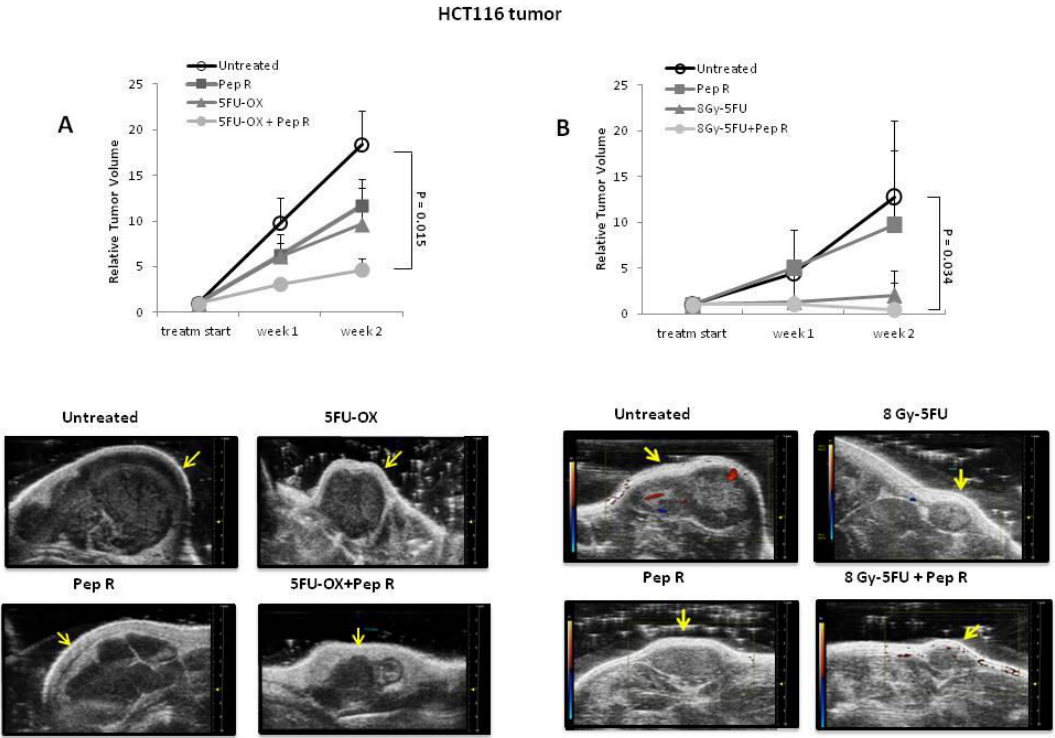
Figure 1. Peptide R reduces HCT116 tumor growth and improves the e ffi cacy of radiotherapy chemotherapeutic agents (RT-CT) in colon cancer HCT116-xenograft. ( A Upper ): Relative tumor volumes ± SEM (6 animals / group). Significance p < 0.05. Repeated measures (RM) ANOVA with Bonferroni post hoc test and correction for multiple testing by Bonferroni’s adjustment. ( A Lower ): tumors high frequency ultrasound (HFUS) conducted at 14 days of treatment (scale bar on the right). ( B Upper ): relative tumor volumes ± SEM (6 animals Control and 4 animals for each treatment group). Significance p < 0.05. RM ANOVA with Bonferroni post hoc test and correction for multiple testing by Bonferroni’s adjustment. ( B Lower ): color doppler high frequency ultrasound (HFUS) representative images of HCT116 tumors (arrow) at 2 weeks of treatment; red spots identify blood flow entering the tumor while blue spots identify blood flow leaving the tumor. Three mice per group; one mouse per group represented.